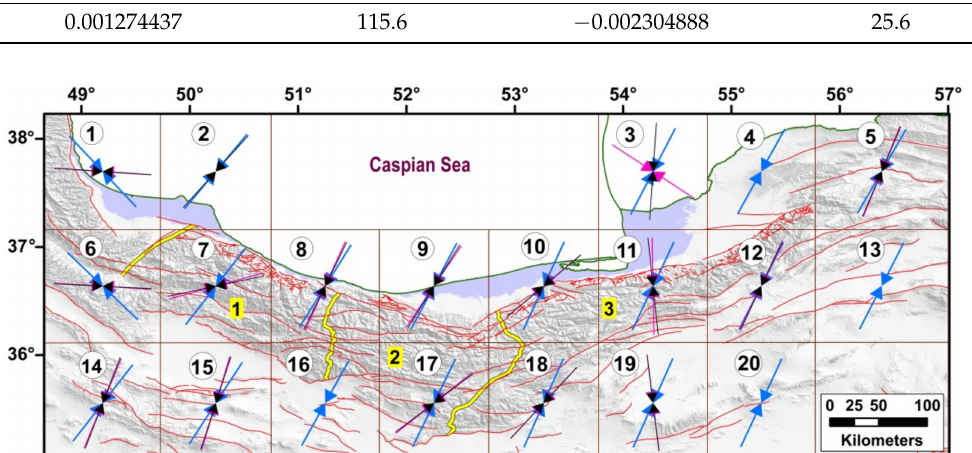
Figure 6. The compression directions of the principal axes resulted from the geodetic strain rates (blue), stress inversion (black), and seismic strain rates (purple). Labels within grids show grid number. Numbers 1, 2, and 3 are location of the West Alborz, Central Alborz, and East Alborz, respectively which are separated by yellow